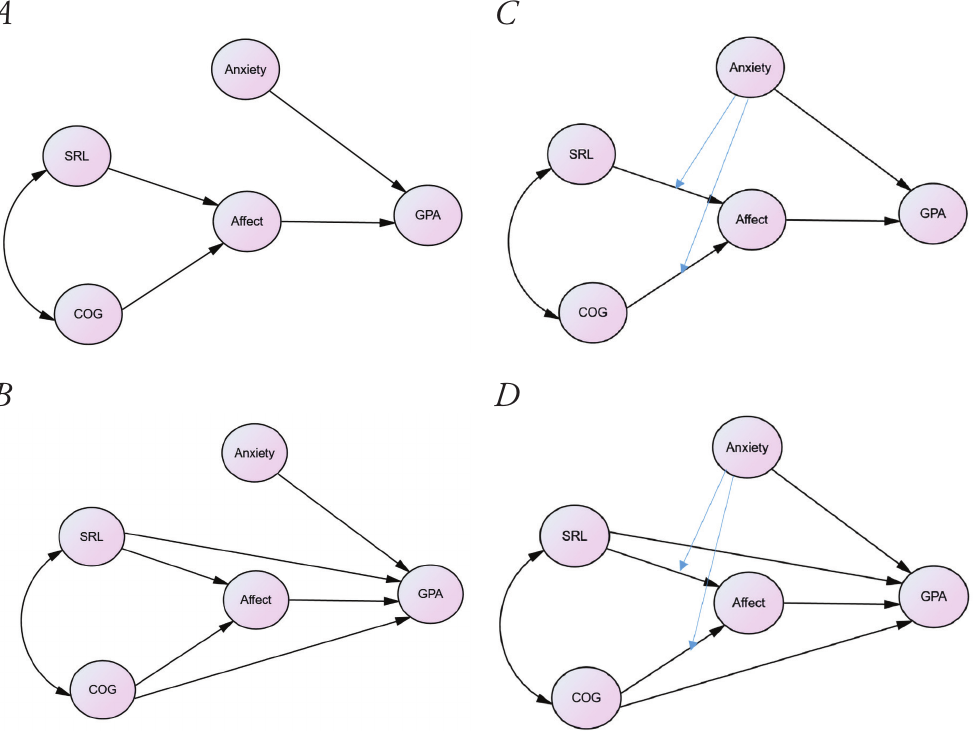
Figure 1. Proposed Models